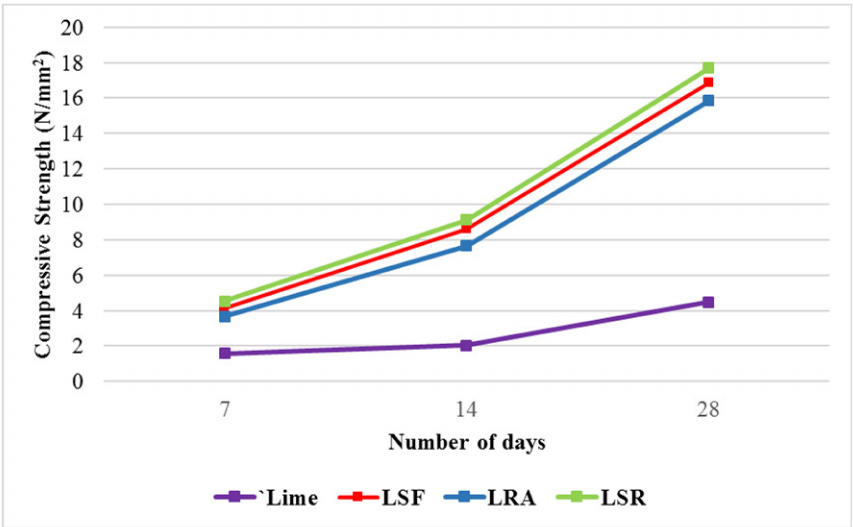
Figure 9. Compressive strength of lime and lime composite